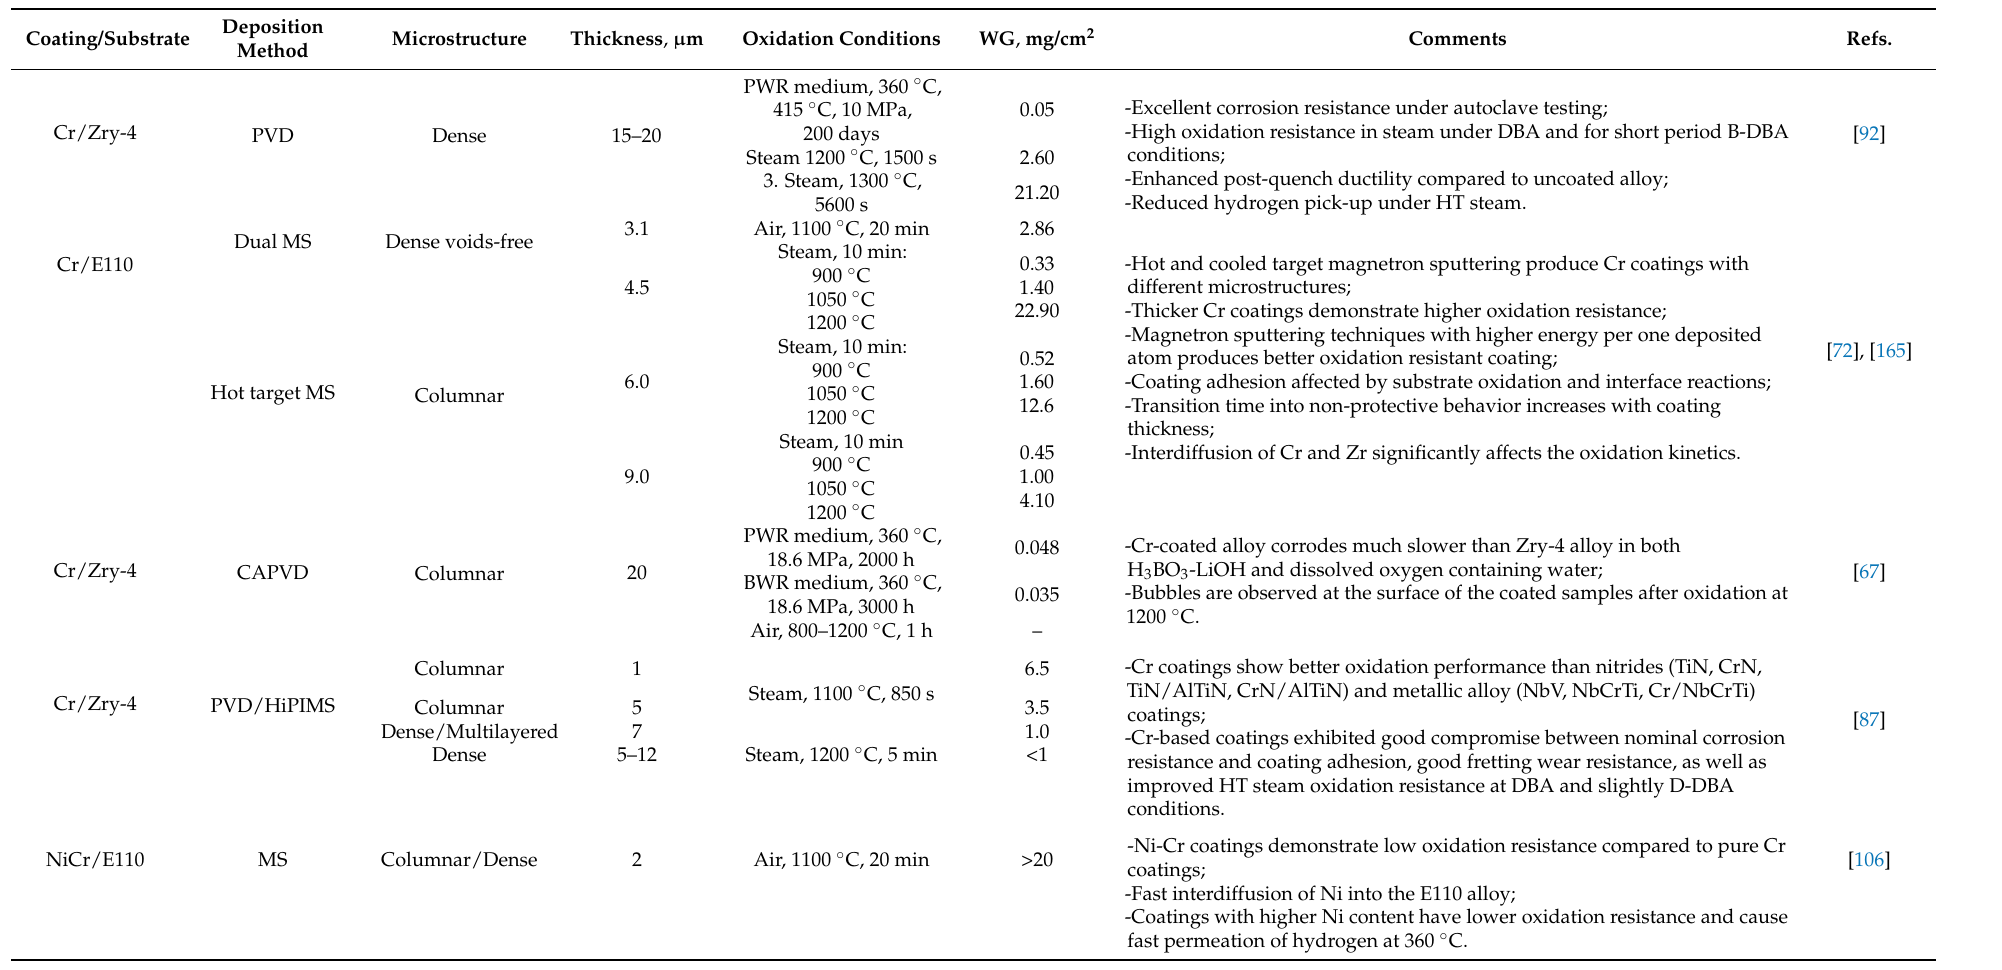
Table 2. Summary of selected protective coatings for Zr-based